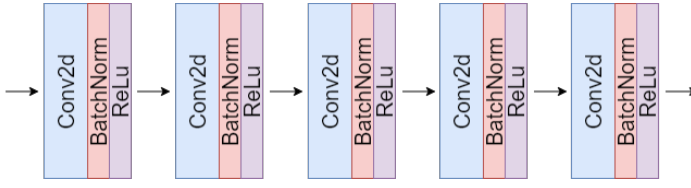
Figure 5. Applying convolution layer to batch